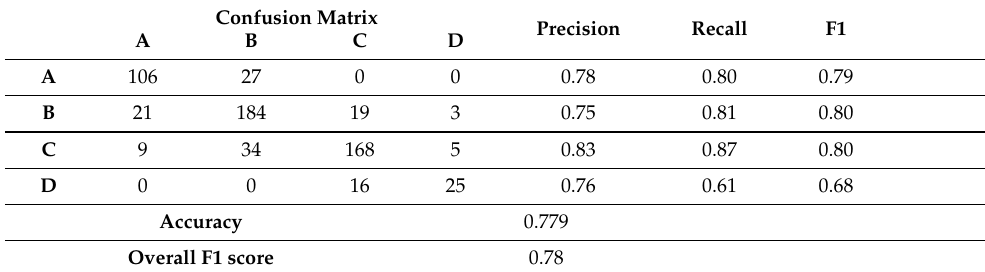
Table 16. Weighted average ensembles with best 5